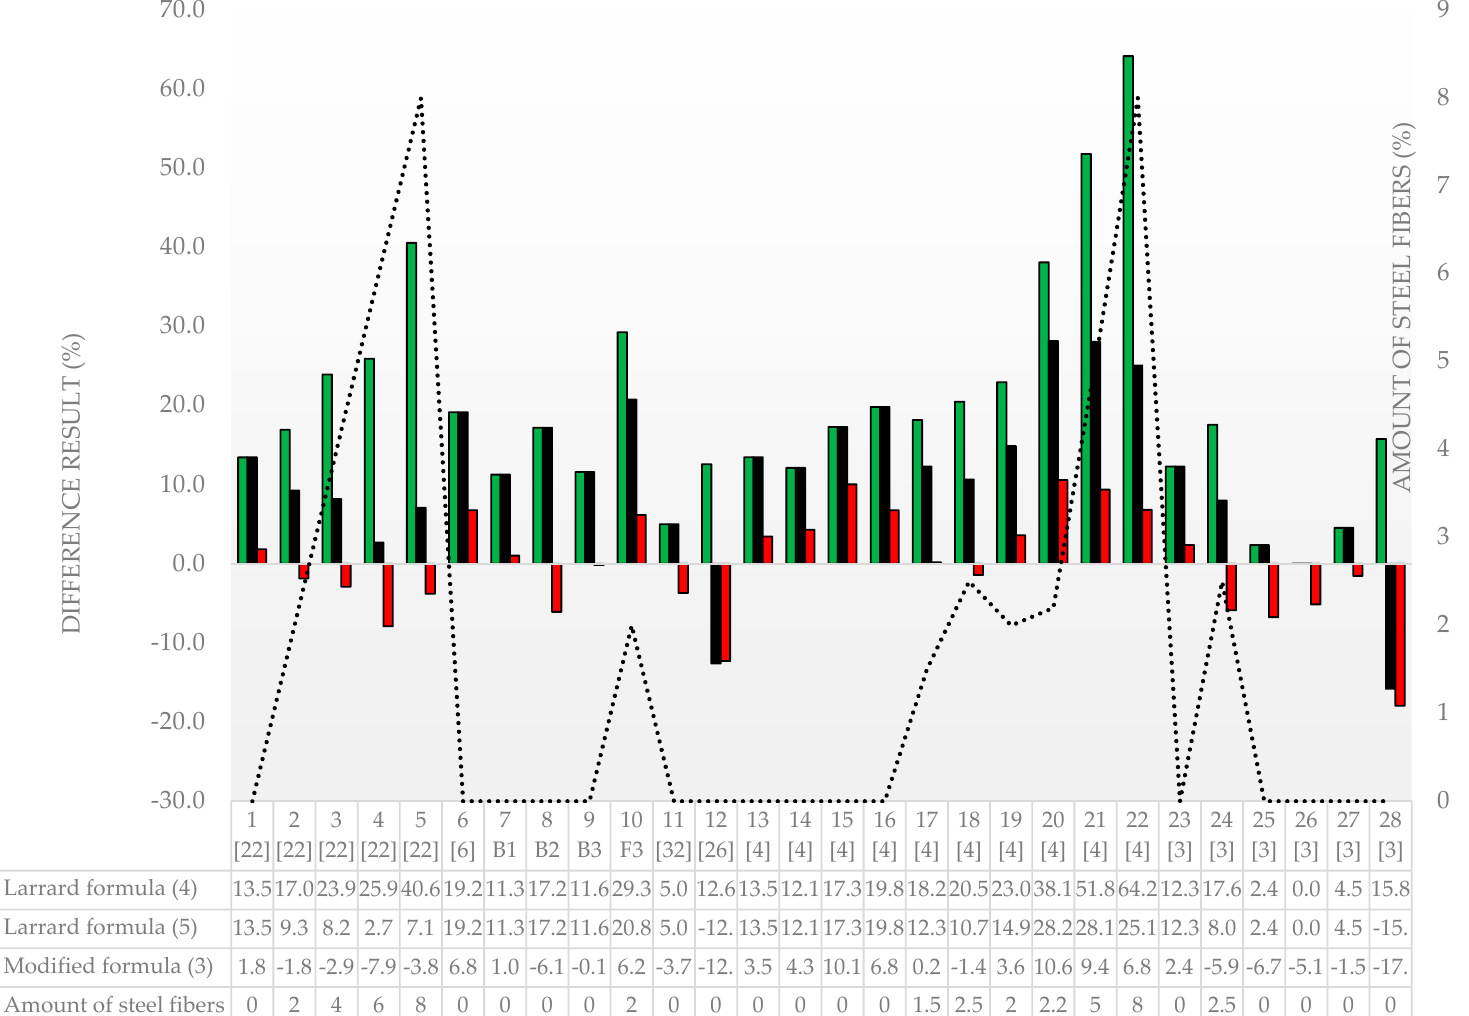
Figure 5. Experimental and design compressive strength for different mix compositions and formulas depending on the amount of steel fibers.